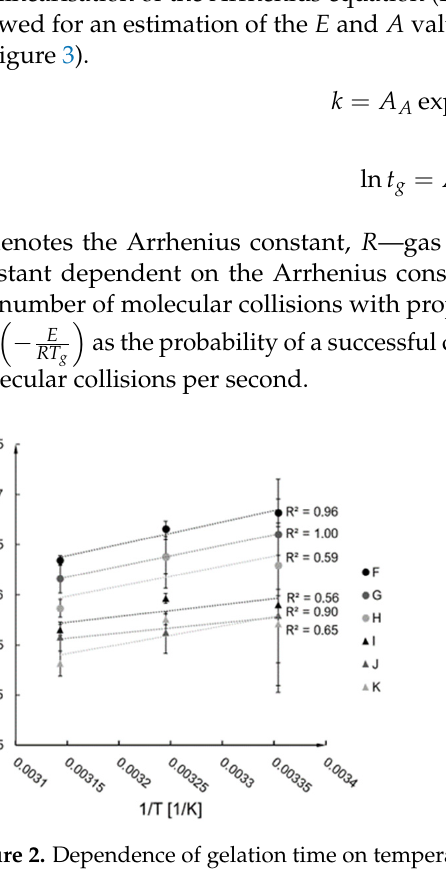
Figure 4. Dependence of probability and probability rate function on catalyst/precursor molar ra- tio. The cellular automaton requires two set parameters: (i) secondary particle concen- tration and (ii) probability of an effective collision. Within